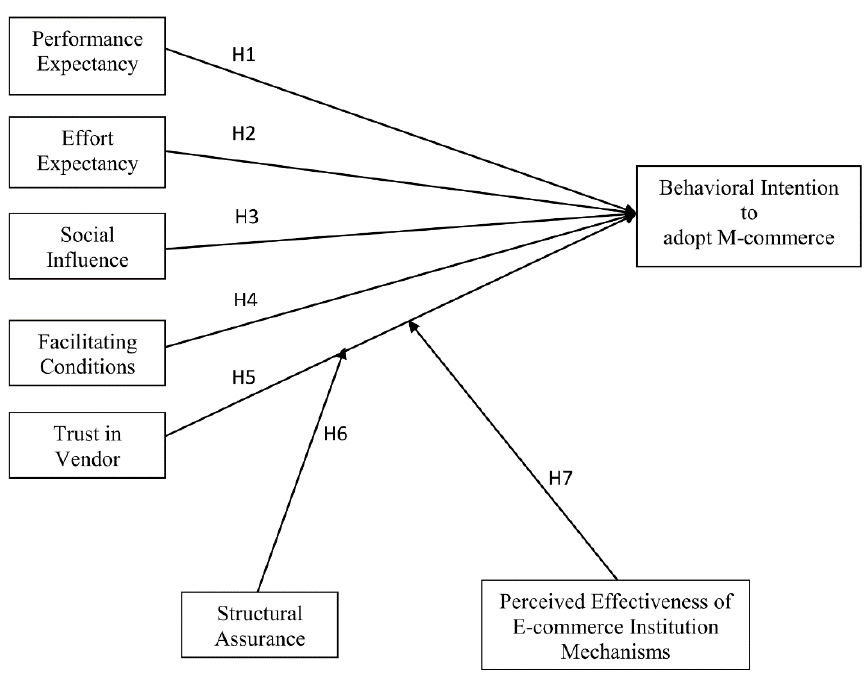
Figure 1. The research model.